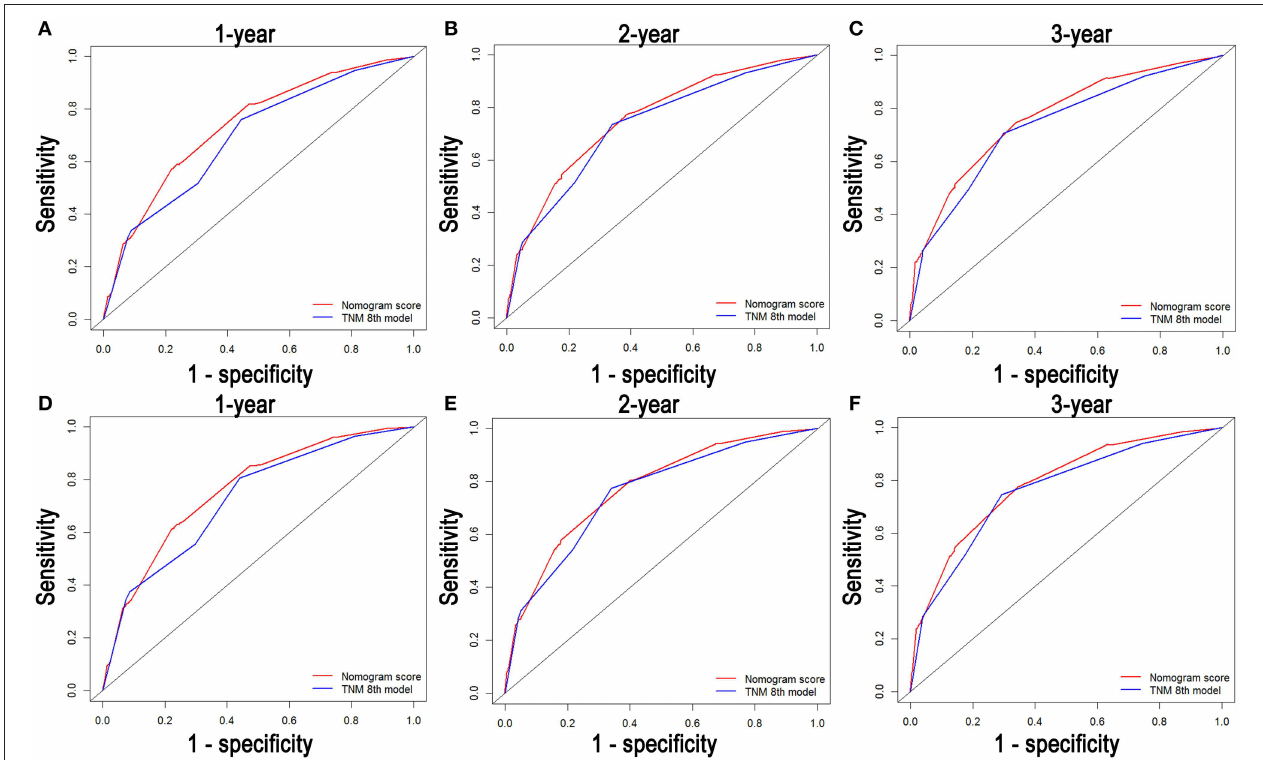
FIGURE 6 | Comparison of the ROC curves of the nomogram and the TNM stage systems for 1-, 2-, and 3-year OS prediction (A–C) and CSS prediction (D–F) .